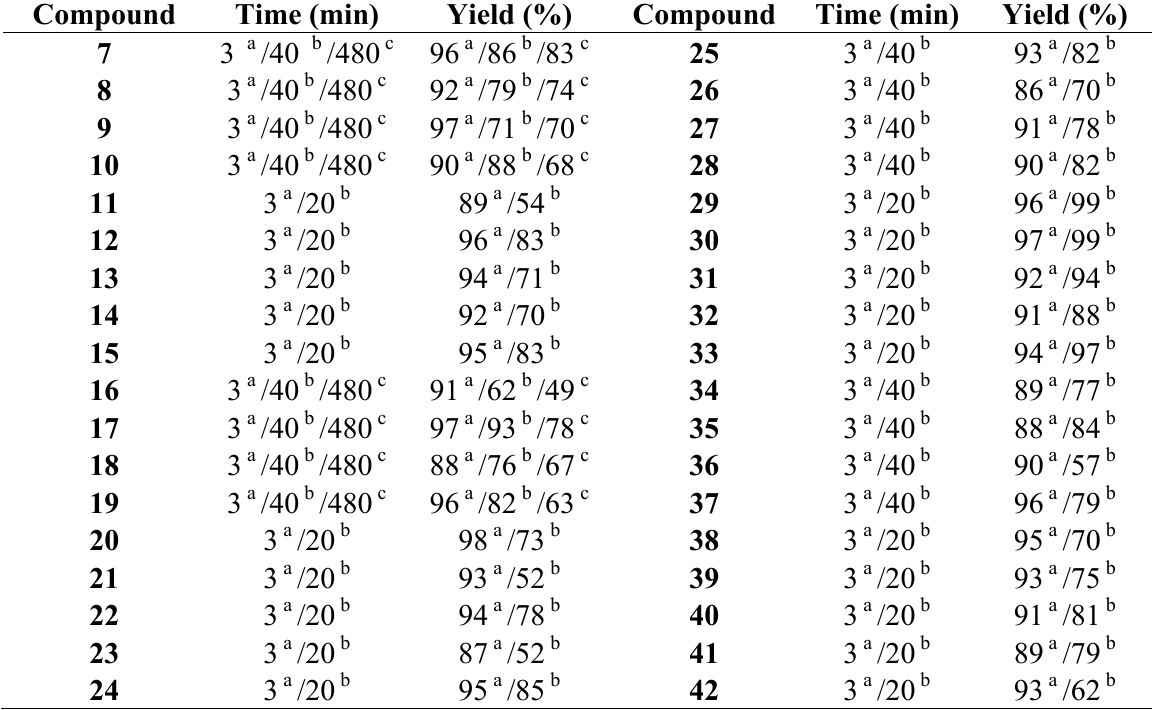
Table 1. Thiosemicarbazone yields and reaction times obtained under microwave irradiation using ethanol as solvent and in solvent free conditions ( 7–42 ), and under traditional reflux ( 7–10 and 16–19